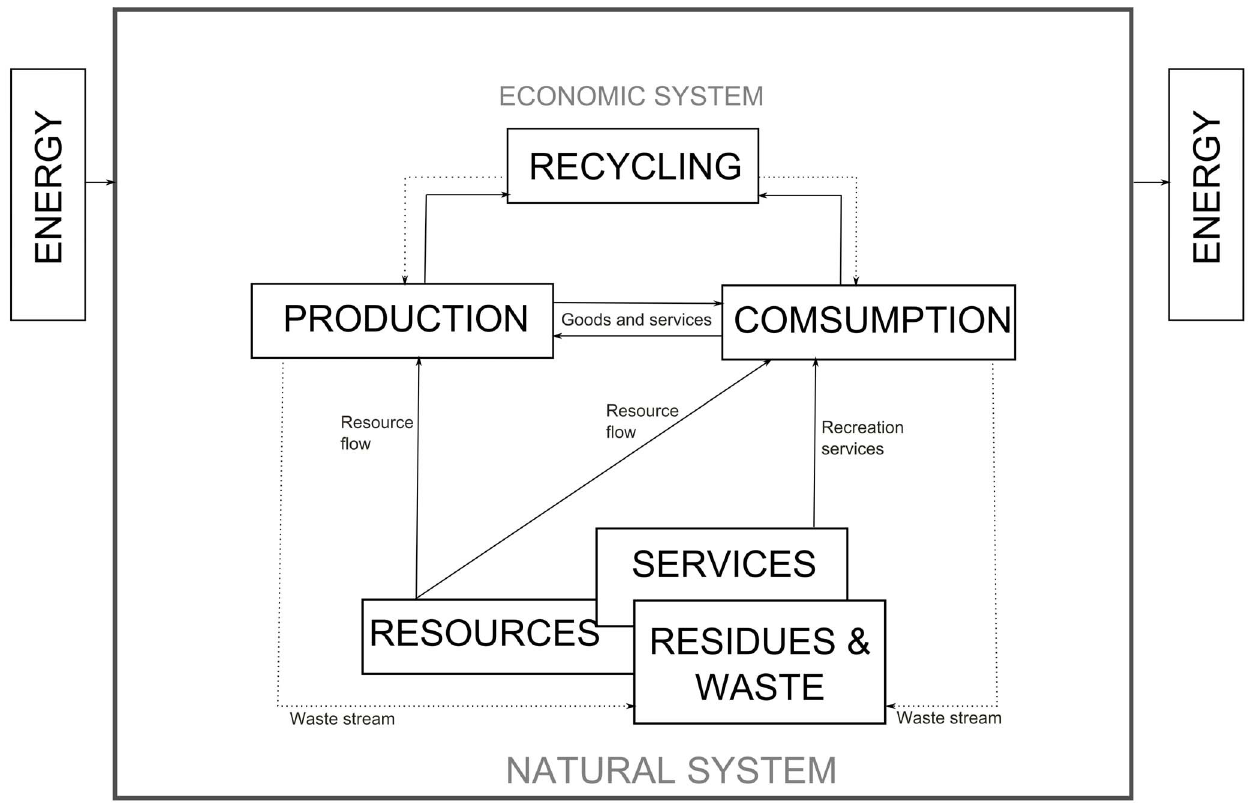
Figure 1. Environment and Economy. Source: Adapted from Ruesga and Dura´n [27] and Del Brio and Junquera [28].